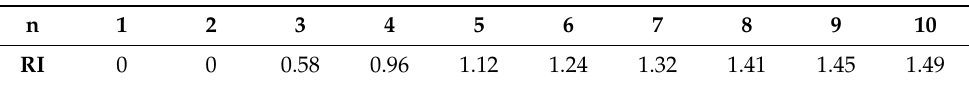
Table A2. RI values